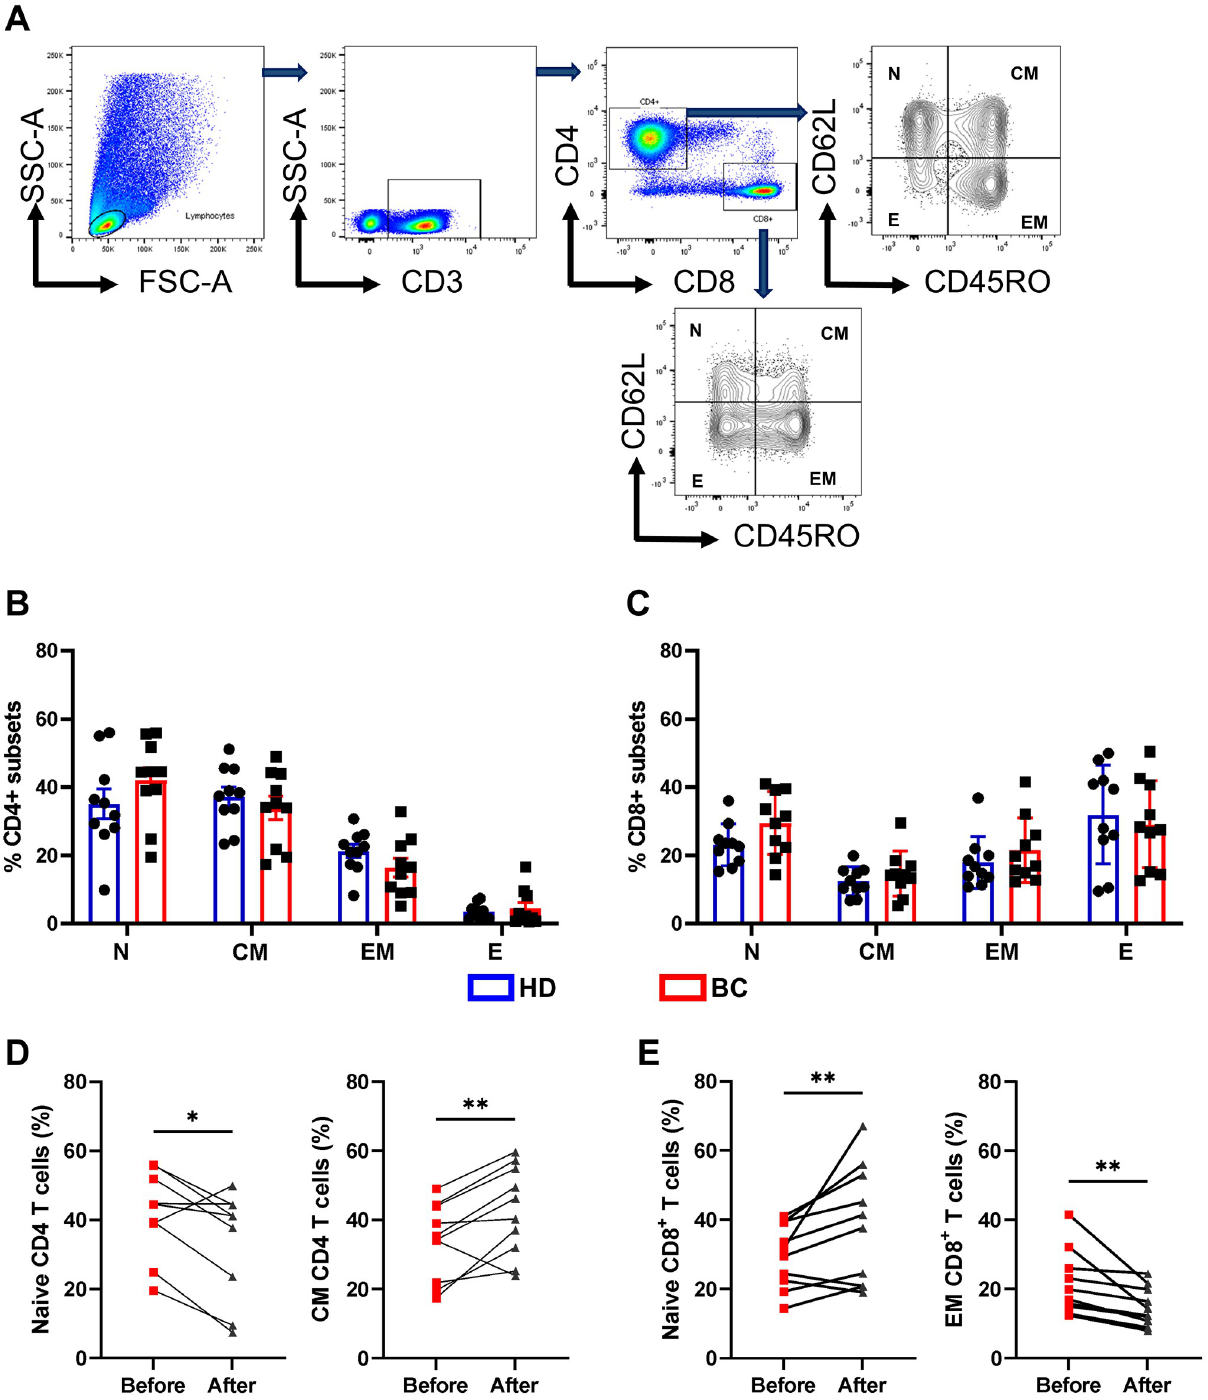
Fig 2. Change in CD4+ and CD8+ T cell subsets in chemotherapy-treated patients. A . Gating strategy used to identify memory population in T cells: CD62L+CD45RO − na ï ve T cells ( N cells), CD62L+CD45RO+ central memory T cells ( CM cells), CD62L − CD45RO+ effector memory T cells ( EM cells) and CD62L − CD45RO − terminal effector T cells ( E cells) within CD3+CD4+ and CD3+CD8+ compartments. B . Scatter point bars showing the percentage of each memory subpopulation in HD (blue box) vs. BC patient’s (red box) in CD4+ and C . CD8 + T cells. D . Frequencies of na ï ve and central memory T cells within total CD4+ compartments in BC patients before and after chemotherapy. E . Frequencies of na ï ve and effector memory T cells within total CD8+ compartments in BC patients before and after chemotherapy (n = 10/group). A nonparametric t -test was performed with unpaired Mann-Whitney test data to compare HD and BC patient’s. A paired nonparametric Wilcoxon test to compare BC patients before and after chemotherapy. Data presented as means ± SEM ( �� p < 0.01; � p < 0.05). https://doi.org/10.1371/journal.pone.0280851.g002 PLOS ONE | https://doi.org/10.1371/journal.pone.0280851 February 10,